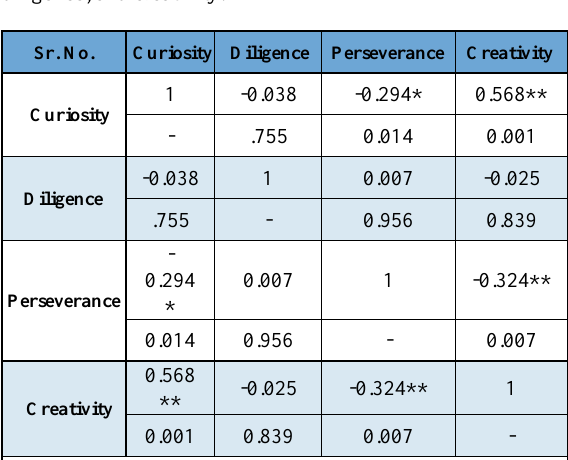
Table 2. Correlation between curiosity, perseverance, diligence, and